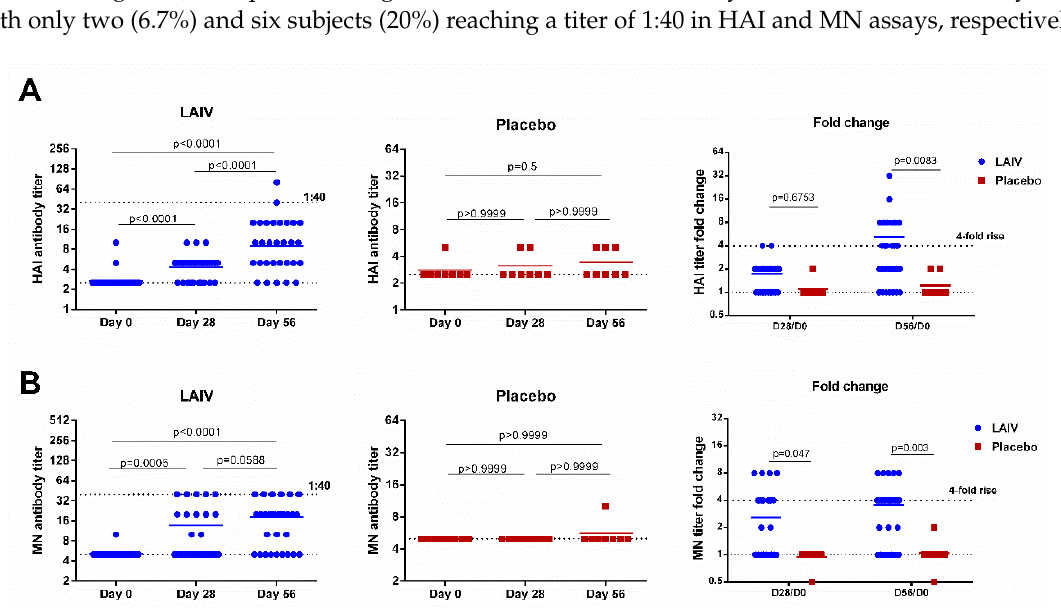
Figure 2. Hemagglutination inhibition and neutralizing antibody titers in subjects immunized with H7N9 LAIV or placebo. ( A ) HAI antibody titers. ( B ) MN antibody titers. Data were analyzed by Wilcoxon Matched Pairs Test (left and middle panels) and two-way ANOVA followed by a Bonferroni multiple comparison test (right panel).